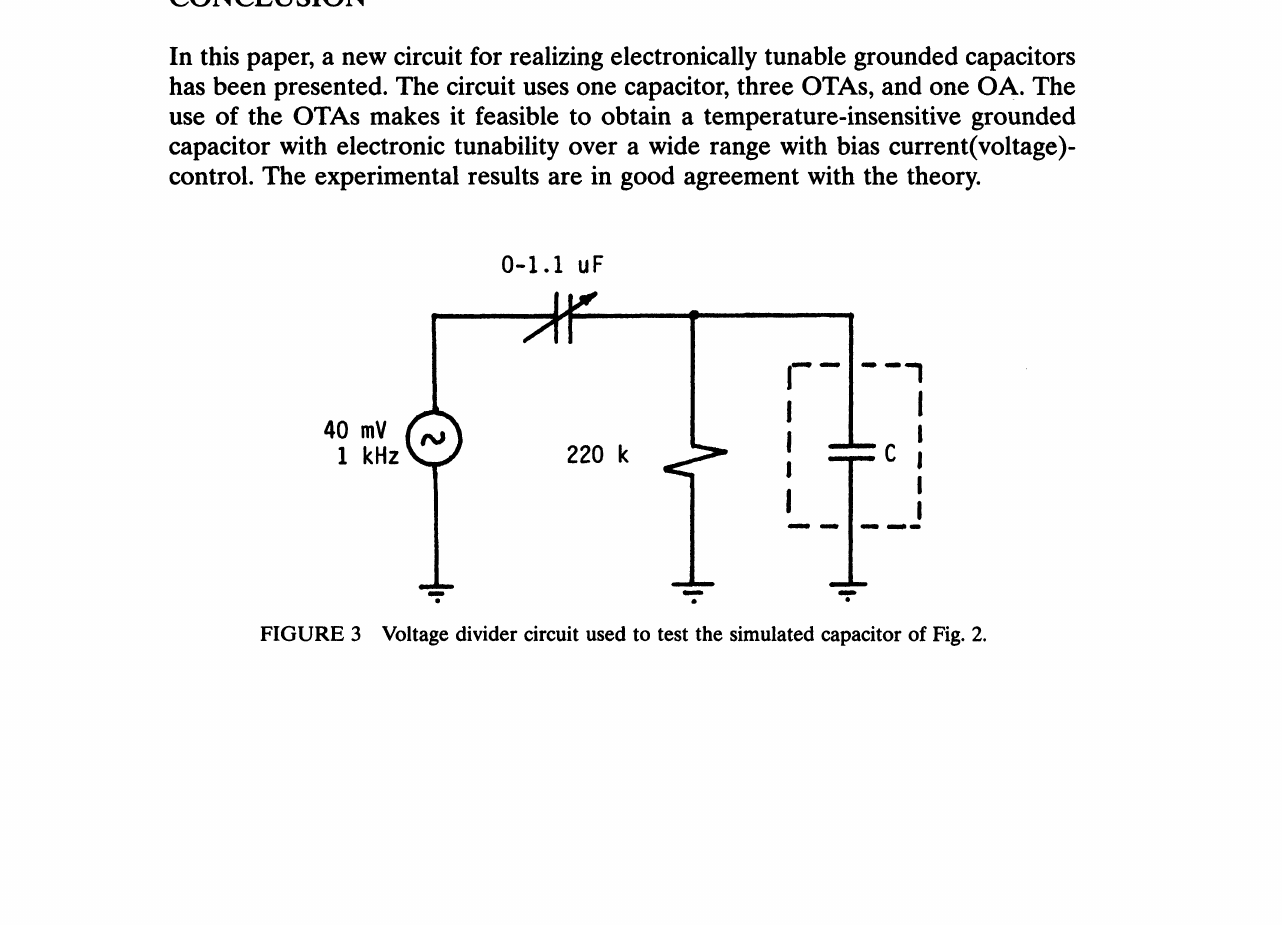
FIGURE 2 Practical realization of an electronically tunable temperature-insensitive positive capacitance.